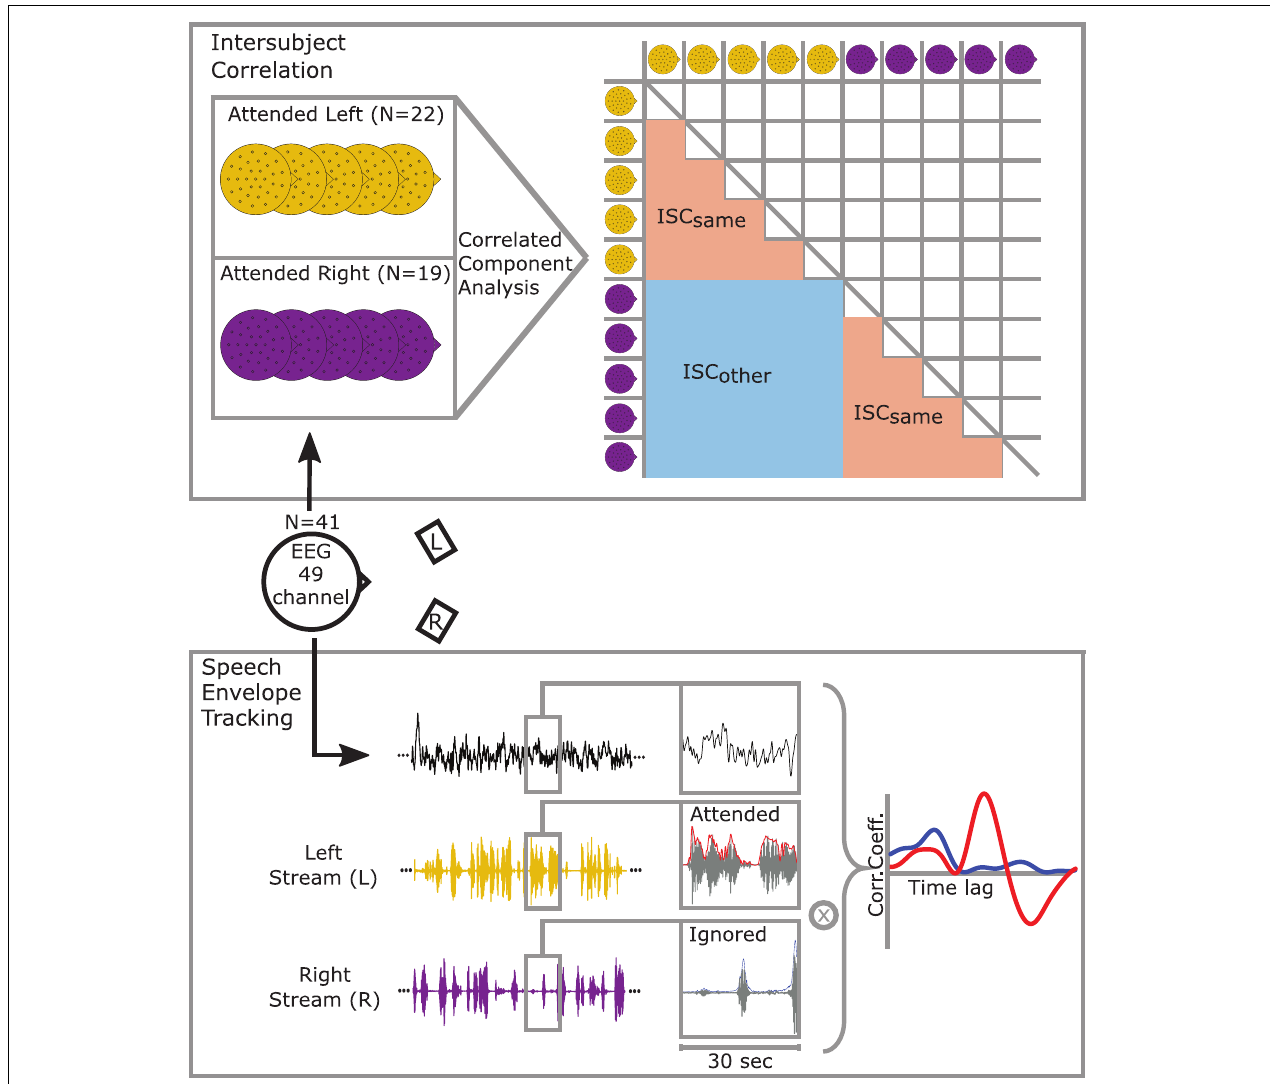
FIGURE 1 | Participants were instructed to attend to one of two simultaneously presented stories while EEG was recorded. Experimental conditions differed in allocation of attention to the story presented from the front left (yellow) or front right (purple). A 49-channel configuration was used for further analysis. (Intersubject correlation) Correlations between participants’ EEG signals were maximized using Correlated Component Analysis. The matrix on the right illustrates that correlations between participants that also attended to the left or right story are categorized as ISC same whereas correlations across conditions are categorized as ISC other . As the correlation matrix is symmetrical one half can be neglected. (Speech envelope tracking) Speech envelope tracking was performed by segmenting the signals into 30 s epochs. For each epoch, the EEG signal of every channel was cross-correlated with the attended (red) and ignored (blue) speech envelope. The figure shows an example when the left stream is attended to, and the right stream